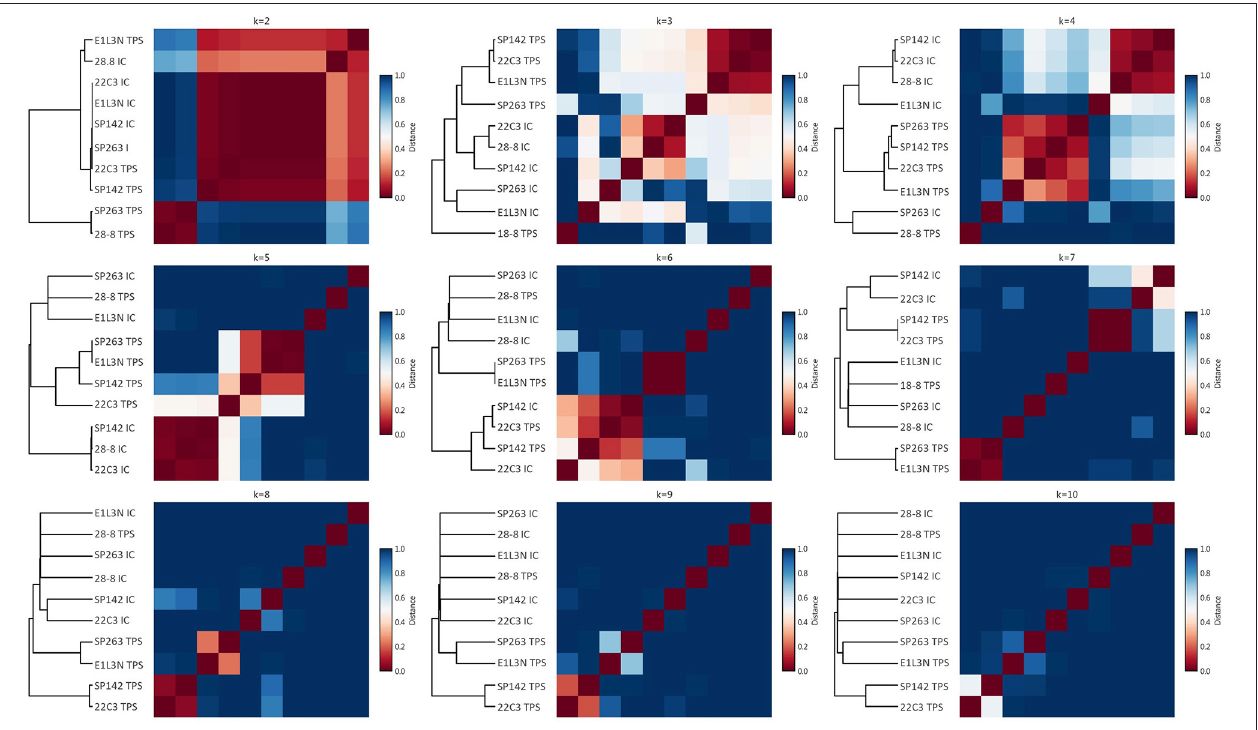
FIGURE 5 | NMF consensus clustering. For varying numbers of clusters (ranks; subplots), NMF consensus clustering was performed; for each rank, the consensus matrix as a measure of cluster stability is shown as a heat plot with red indicating perfect consensus for a given pair of clones across stochastic runs (the clones end up in the same cluster all the time); the dendrogram on the left indicates relative cluster similarity by the respective lengths of the horizontal lines.